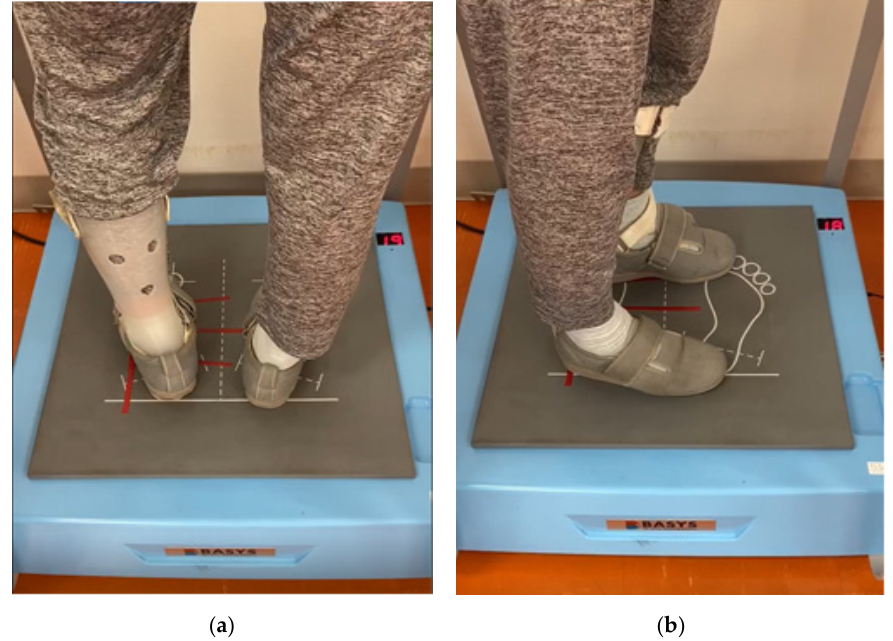
Figure 1. The foot position during balance exercise using real-time feedback system (BASYS). ( a ) Anterior-posterior direction exercise. ( b ) Medial-lateral direction exercise.